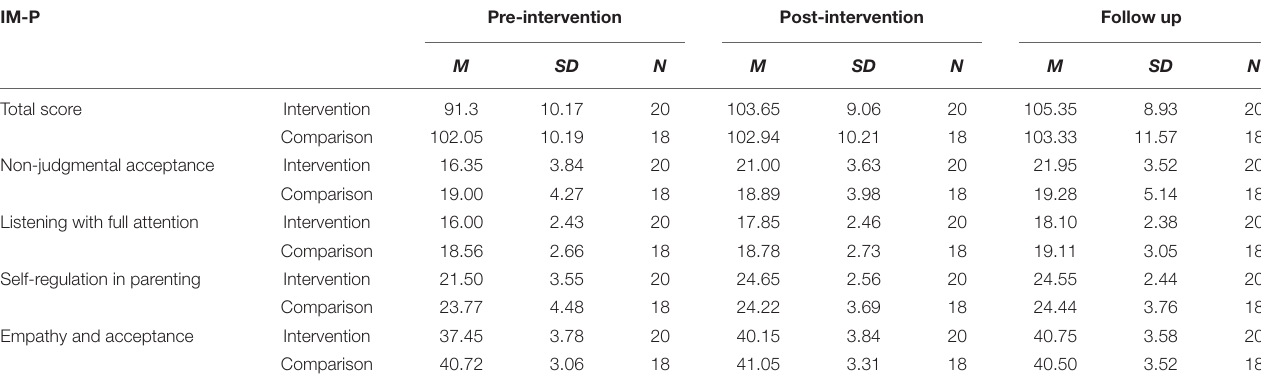
TABLE 3 | IM-P means and standard deviation scores.